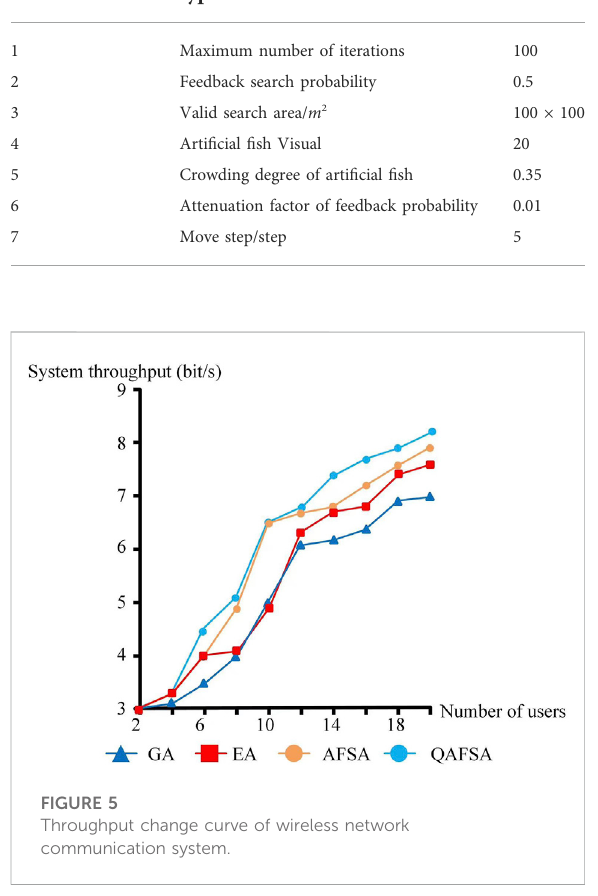
FIGURE 7 Fairness change curve of multi-user system resource allocation